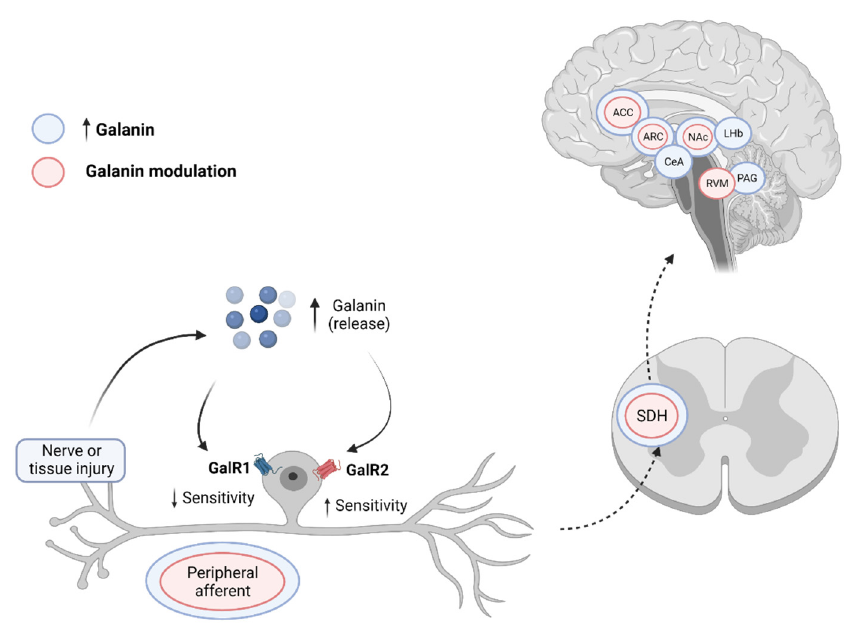
Figure 2. Mechanism of action of galanin in chronic pain conditions. Under normal situations, peripheral nerve injury or inflammation induces an increase in galanin levels that act upon GalR1 receptors, inhibiting nociceptive transmission. In chronic pain conditions, there is an upregulation of GalR2 receptors in peripheral nerve afferents and their correspondent dorsal root ganglia (DRG), which causes hypersensitivity to noxious stimulation and consequent mechanical and thermal hyperalgesia. Peripheral injury was also shown to increase galanin levels at both a spinal and supraspinal level, and its administration produces an antinociceptive effect upon nociceptive processing. (ACC—anterior cingulate cortex; ARC—arcuate nucleus of the hypothalamus; CeA—central nucleus of the amygdala; LHb—lateral habenula; NAc—nucleus accumbens; PAG—periaqueductal gray; RVM—rostral ventromedial medulla; SDH—spinal dorsal horn). Created in BioRender.com.